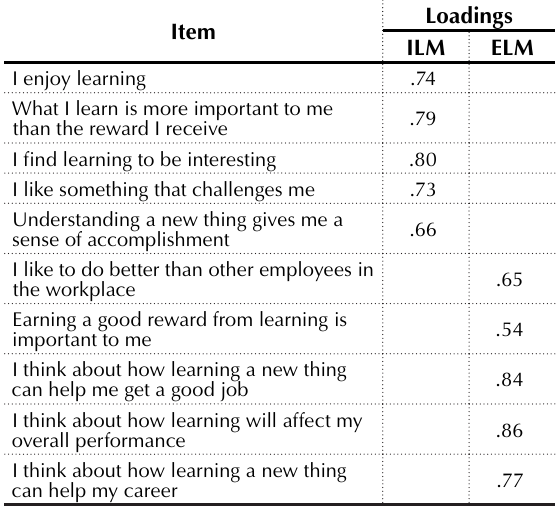
Table 1. Discriminant validity for intrinsic and extrinsic learning motivation Item